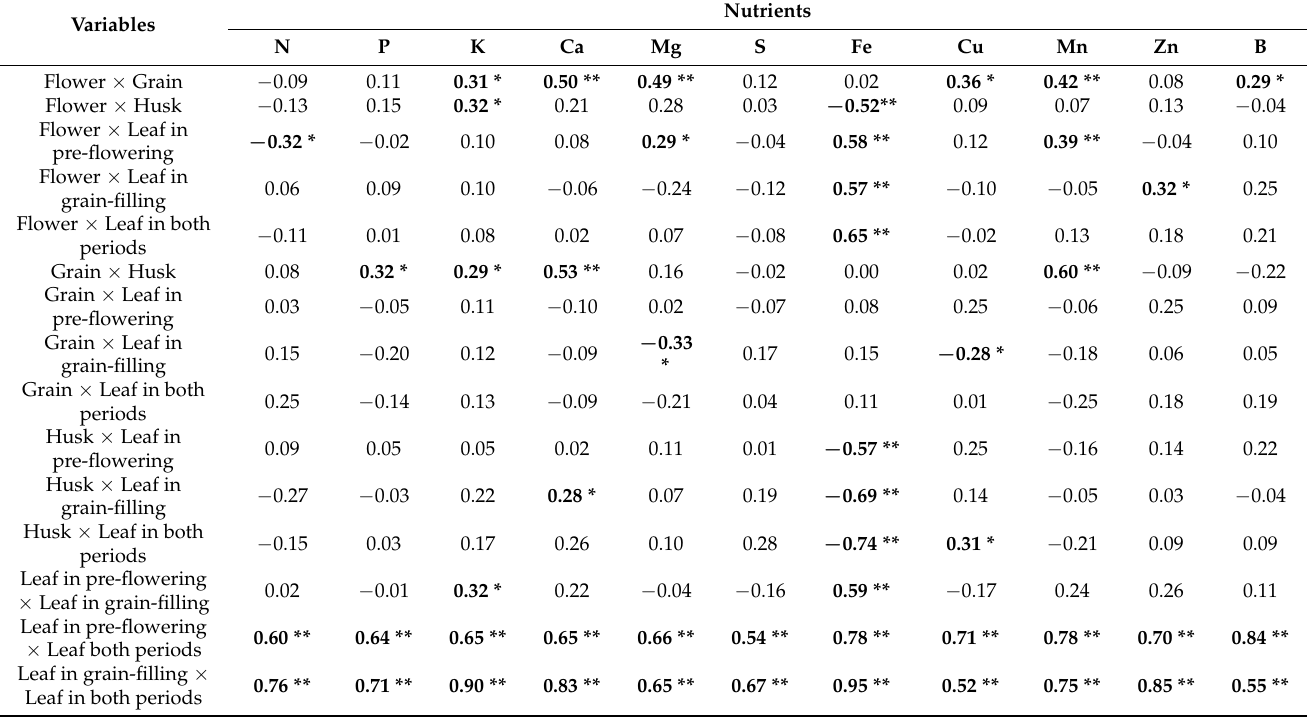
Table 9. Spearman correlation coefficients for macro- and micronutrient concentrations in the flowers, grains, husks, and leaves of 16 genotypes of Coffea canephora . Alta Floresta D’Oeste, Rond ô